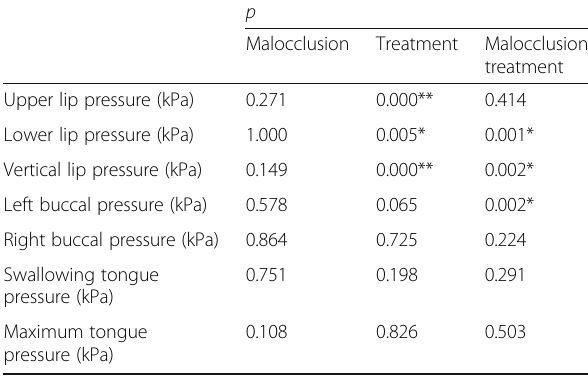
Table 3 Two-way ANOVA results for the pressure measurements